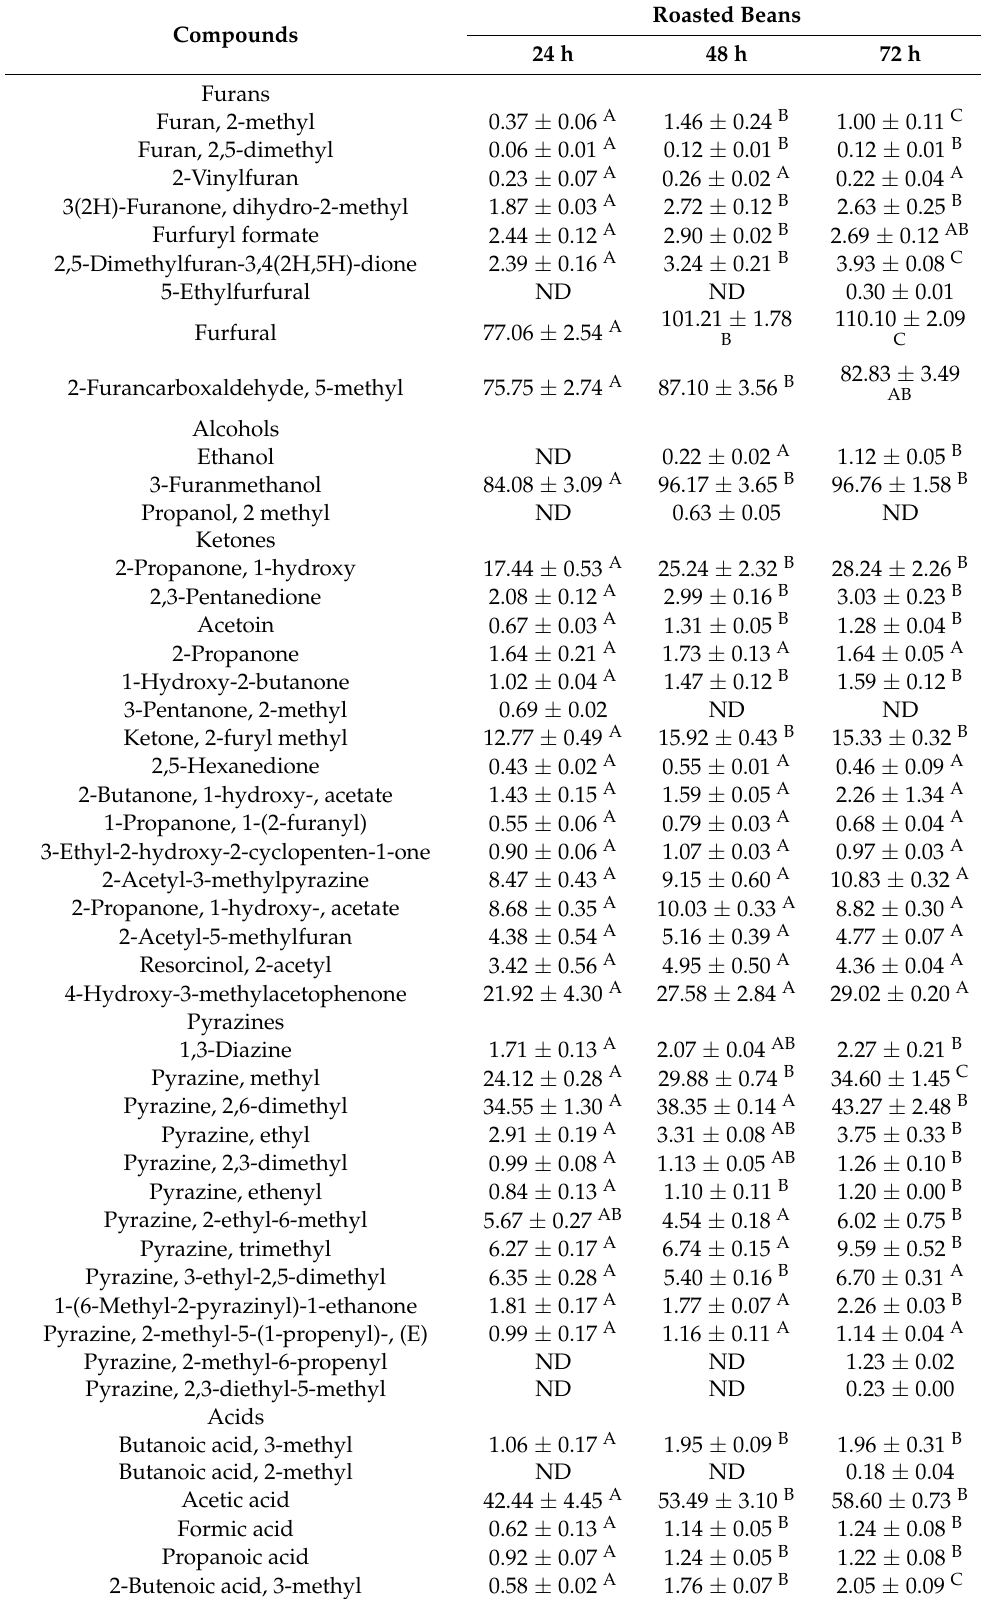
Table 4. Volatile compounds (area × 10 5 ) identified in roasted beans.